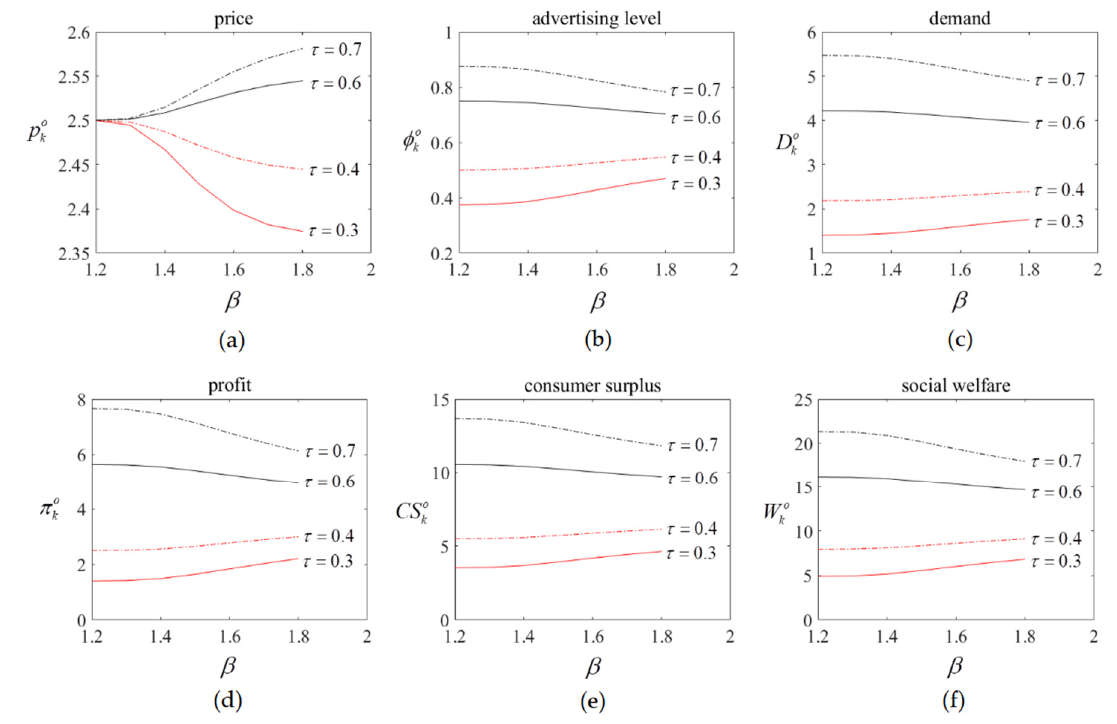
Figure 3. The effects of consumer mobility on the market outcomes: ( a ) the effect on price; ( b ) the effect on advertising level; ( c ) the effect on demand; ( d ) the effect on profit; ( e ) the effect on consumer surplus; and ( f ) the effect on social welfare.